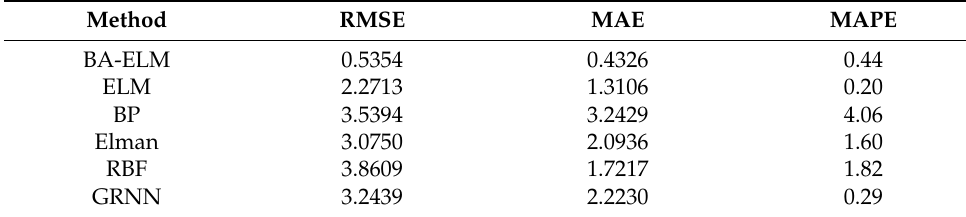
Table 6. Comprehensive comparison table of RMSE, MAE, and MAPE.